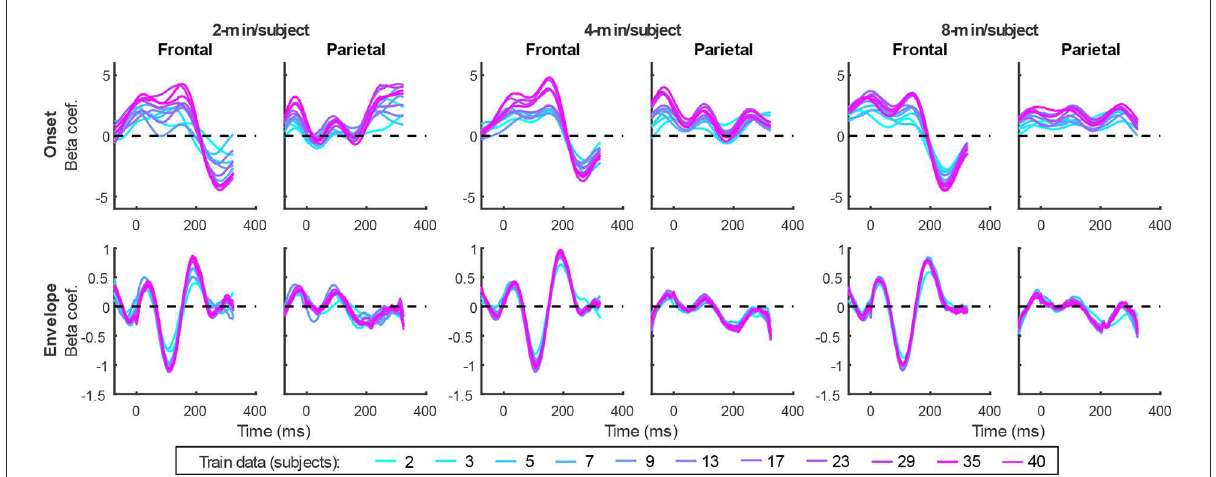
FIGURE12 Average generic model TRF time courses for onset (top row) and envelope (bottom row) features from the denser model trained with 2-min ( left pair of columns), 4-min ( middle pair of columns), and 8-min ( right pair of columns) of data per subject. TRFs estimated using different amounts of data are depicted in different colors (see legend at the bottom of the figure). Note that the sharp deflections in envelope response around t = 0ms reflect mild leakage of electrical artifact from earphones into the EEG signal.